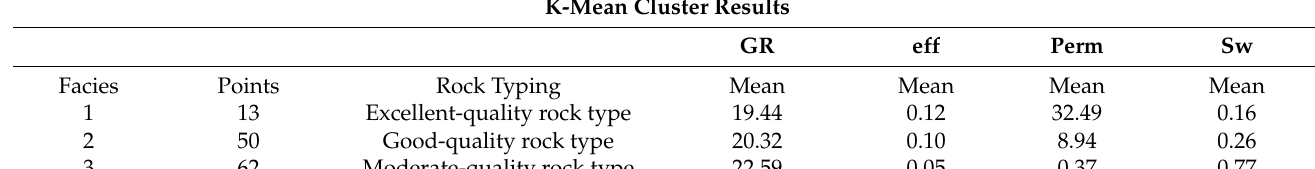
Table 1. The results of “cluster means” plus other statistics of user data for each cluster.